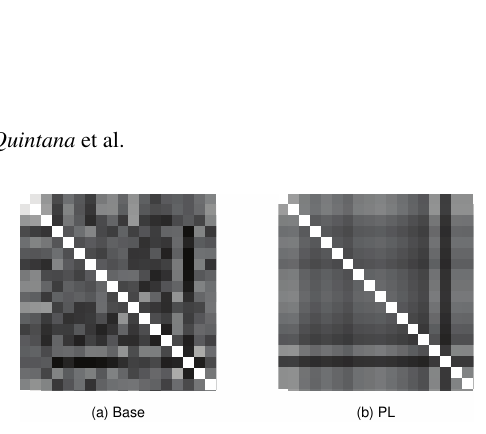
Fig. 3. Correlation matrices. Base vs Plerou et al. filtering.